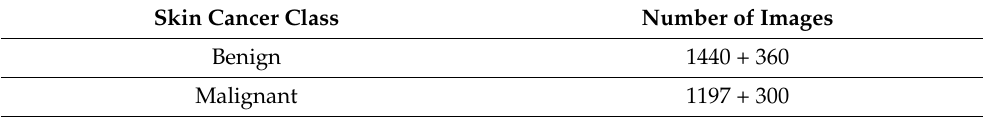
Skin Cancer Class